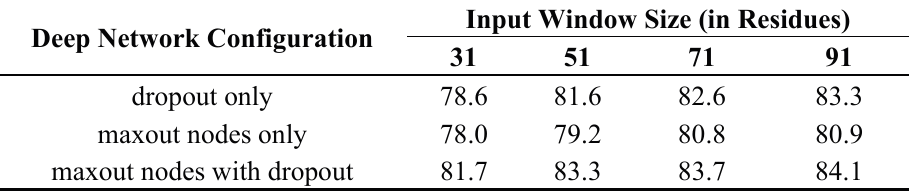
Table 6. AUC for disorder predictions by input window size on the D01111_TEST dataset.